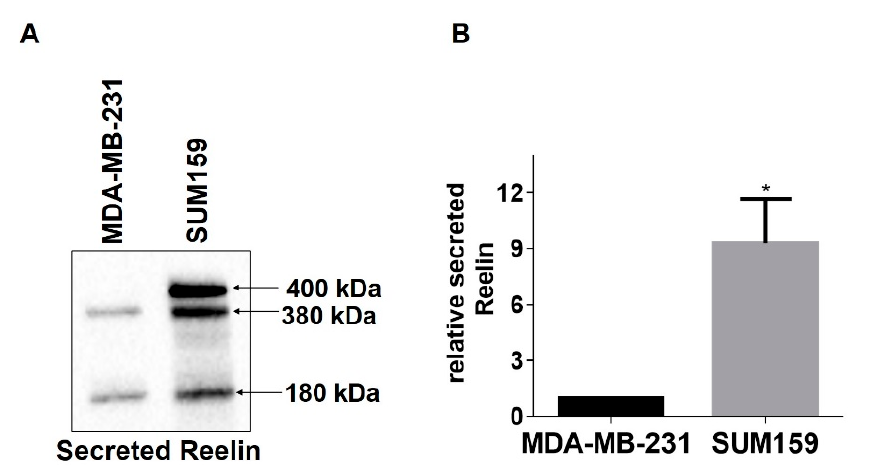
Figure 4. SUM159 cells secrete higher amounts of Reelin protein than MDA-MB-231 cells. ( A ) Representative Western blot of secreted Reelin protein in concentrated conditioned medium collected from MDA-MB-231 or SUM159 cells. Arrows indicate previously described Reelin fragments (400 kDa, 380 kDa, 180 kDa) [30,31]. ( B ) Graph shows quantification of Reelin by Western blot of SUM159 relative to MDA-MB-231 cells. Signals for the different Reelin fragments were combined for each cell line. Data are average +/ − SEM, n = 3; * p ≤ 0.05, unpaired t -test.